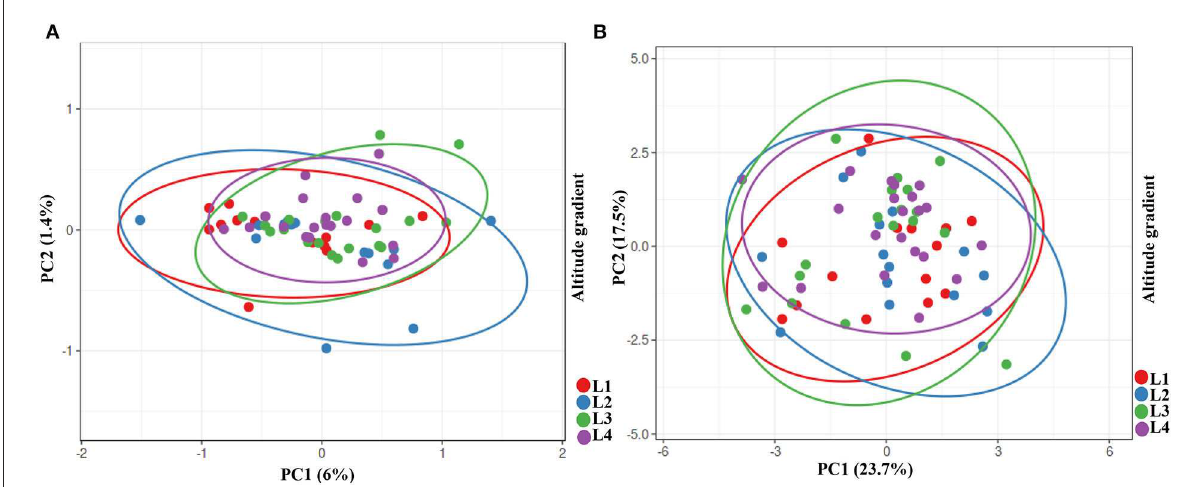
FIGURE6 PCA analysis of growth parameters of wheat, maize and canola and comparing isolates in whole. (A) Growth parameters of wheat, maize and canola in response to isolates from gradient elevation. (B) Batching of isolates based on their effects on plants and their stresses